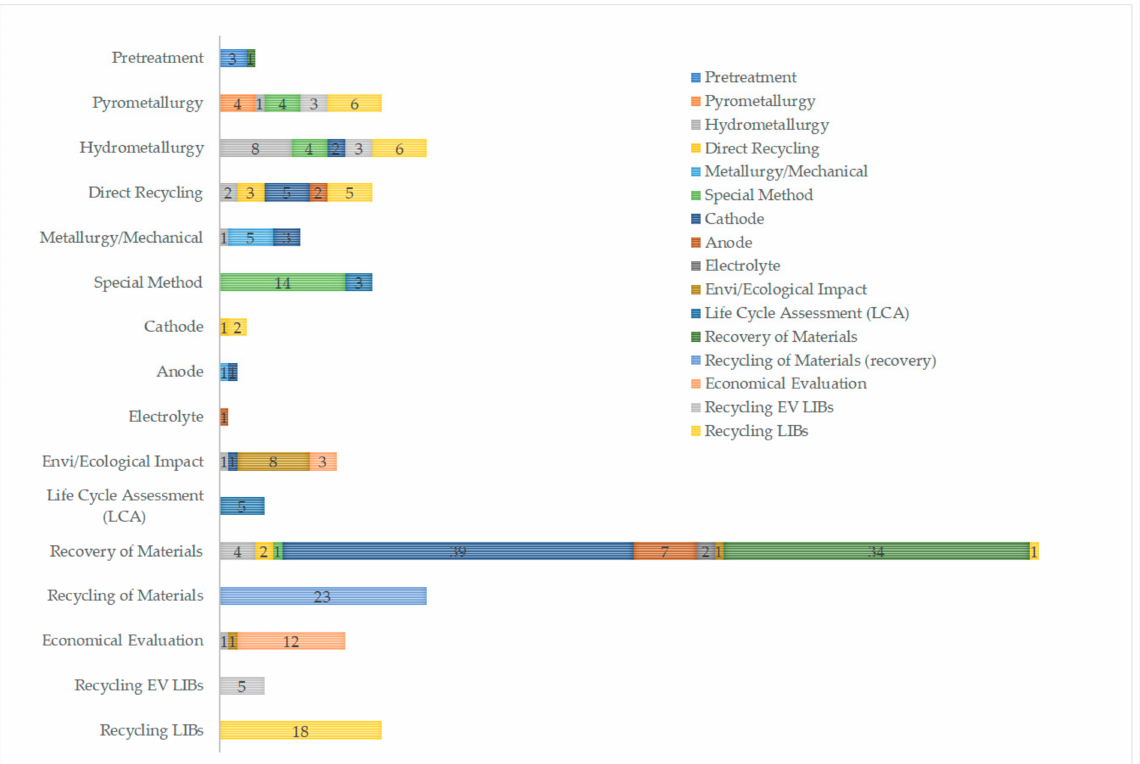
Figure 2. Total distribution and content overlap for publication selected according to the literature review in categories.